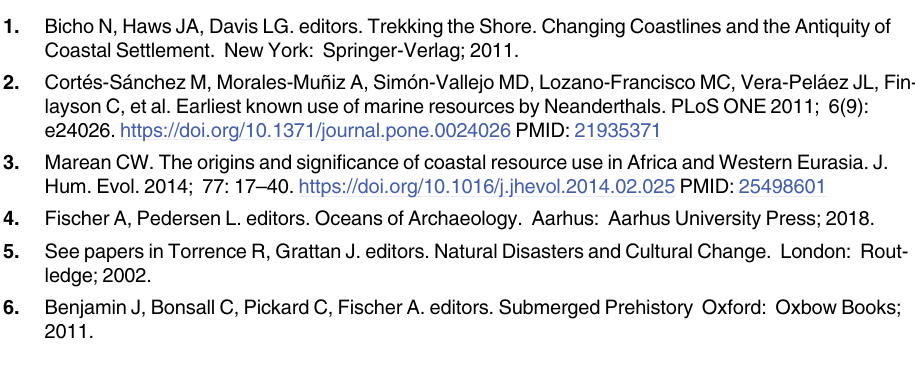
S7 Fig. Artist reconstruction of the PN village and the sea wall (Drawing J. McCarthy and E.